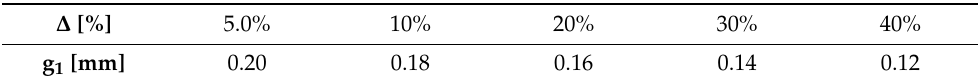
Table 1. Variation in FBW as a function of BPF gap